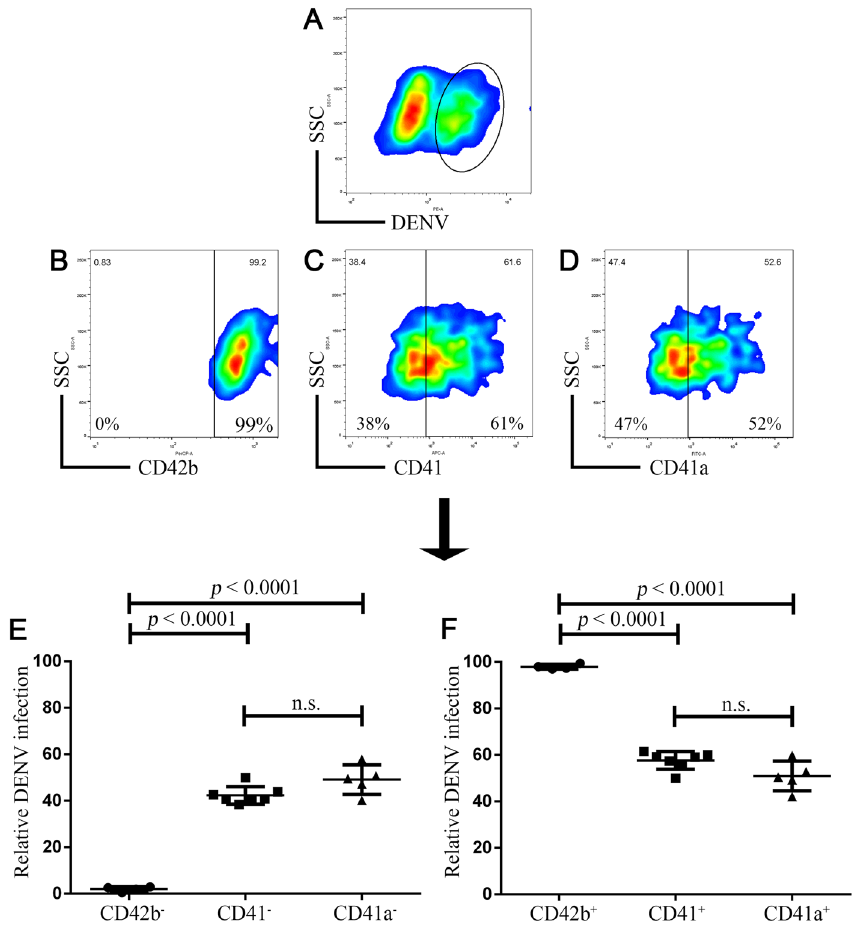
Figure 2. Specificity of CD42b, CD41 and CD41a in dengue virus infection. The cells from Fig. 1 were further analyzed. ( A ) Intracellular DENV + cells were firstly gated (black eclipse) and characterized with surface platelet receptors (( B ) CD42b, ( C ) CD41, ( D ) CD41a). The percentage of DENV + cells after this gating was represented as a relative DENV infection. ( E ) The relative DENV infection in cells without expressing CD42b (n = 4), CD41 (n = 7) and CD41a (n = 5). ( F ) The relative DENV infection in cells with expressing CD42b (n = 4), CD41 (n = 7) and CD41a (n = 5). Error bars represent mean ± SD. Statistical significance was determined by using one-way ANOVA